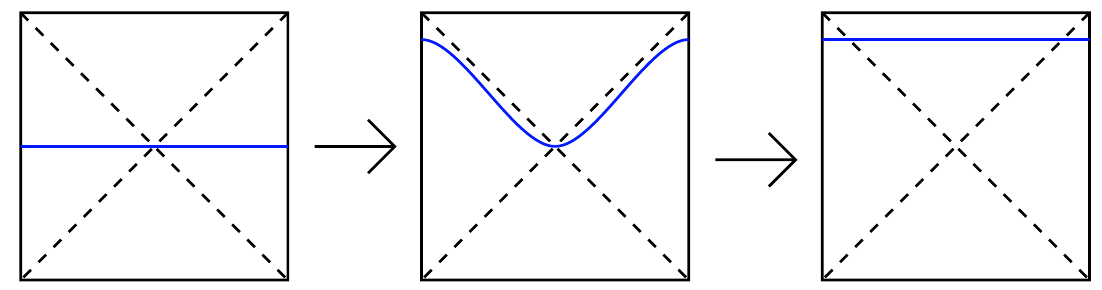
Figure 1 . Di(cid:11)erent kinds of time evolution in the bulk and boundary: the endpoints of a bulk timeslice are moved up and down using the ADM Hamiltonian, while the interior of the slice is evolved using the Hamiltonian constraint. Since the Hamiltonian constraint is zero on physical states, the second two slices describe the same CFT